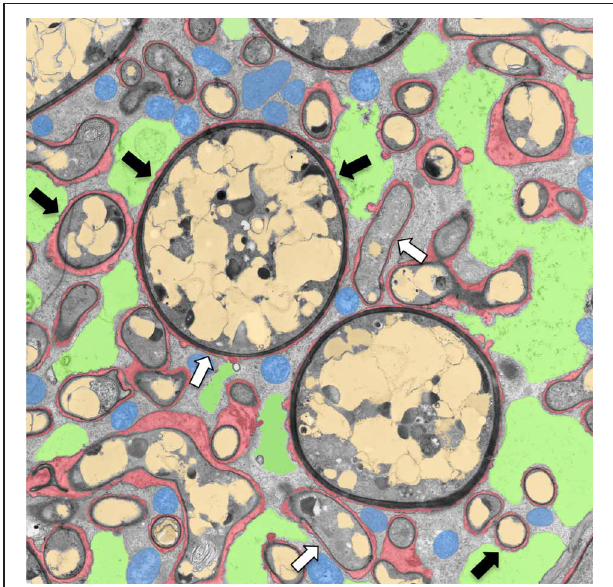
FIGURE 1 | Transmission electron micrograph of a cortical cell of P. hybrida colonized by G. intraradices ( Rhizophagus irregularis ). For clarity, cellular components are pseudocolored as follows: green, fragmented plant vacuole; blue, plant mitochondria and plastids; light brown, fungal vacuoles; red, symbiotic interface. Note the very close contact of the periarbuscular membrane (PAM) with fungal hyphae (white arrows), and the proximity of the tonoplast with the PAM (black arrows).